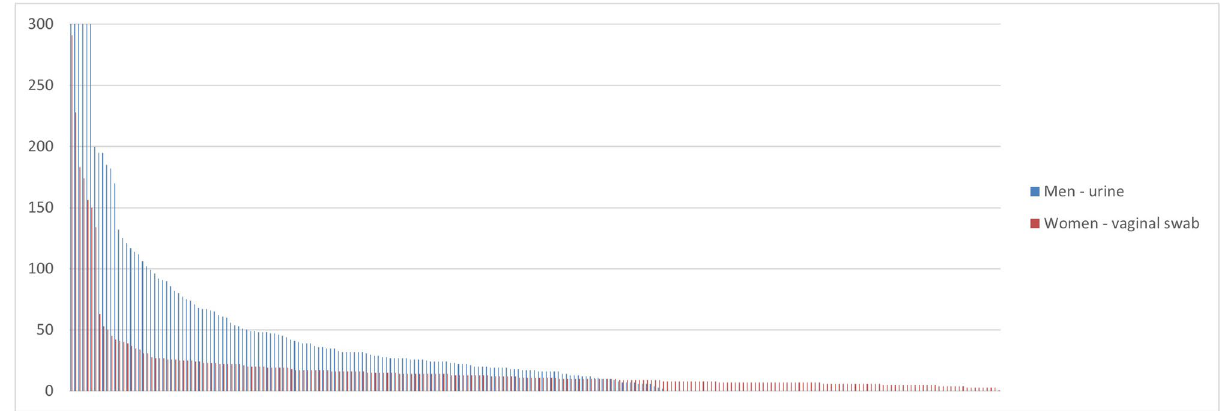
Figure 1. Frequency distribution of the tPCr in urine samples (blue) and vaginal samples (red) from patients from cohort 1. Each bar indicates an individual patient.